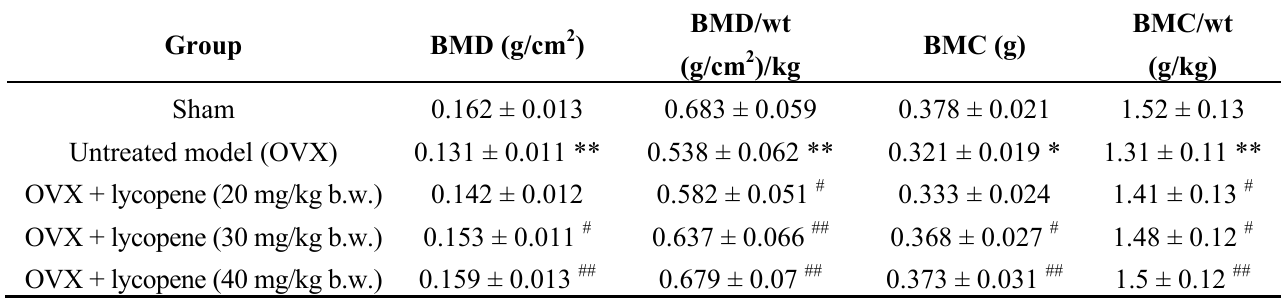
Table 4. Effect of lycopene on BMD, BMD/wt, BMC and BMC/wt values in experimental rats. BMC/wt BMD/wt BMC (g) Group BMD (g/cm 2 ) (g/kg) (g/cm 2 )/kg Sham 0.162 ± 0.013 0.683 ± 0.059 0.378 ± 0.021 1.52 ± 0.13 Untreated model (OVX) 0.131 ± 0.011 ** 0.538 ± 0.062 ** 0.321 ± 0.019 * 1.31 ± 0.11 ** OVX + lycopene (20 mg/kg b.w.) 0.142 ± 0.012 0.582 ± 0.051 # 0.333 ± 0.024 1.41 ± 0.13 # OVX + lycopene (30 mg/kg b.w.) 0.153 ± 0.011 # 0.637 ± 0.066 ## 0.368 ± 0.027 # 1.48 ± 0.12 # OVX + lycopene (40 mg/kg b.w.) 0.159 ± 0.013 ## 0.679 ± 0.07 ## 0.373 ± 0.031 ## 1.5 ± 0.12 ##